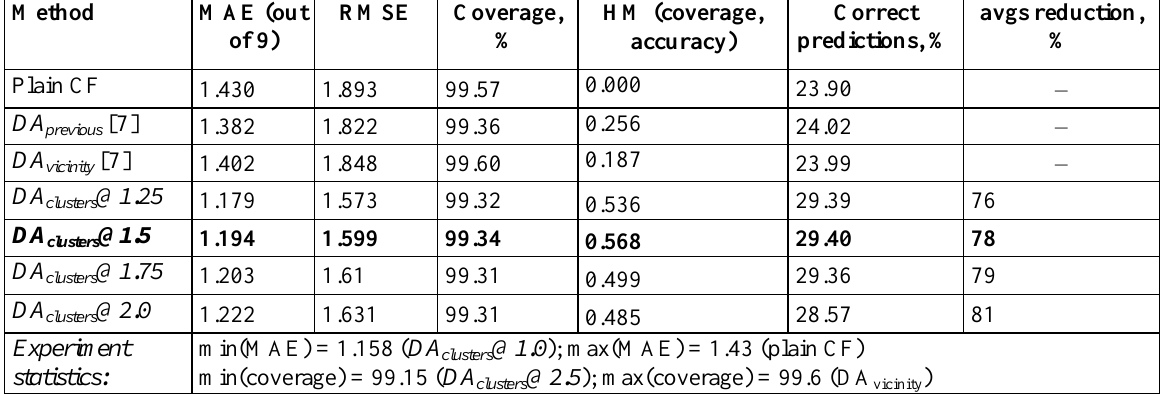
Table 8. MovieLens “Latest 100K, Recommended for education and development (small)” dataset